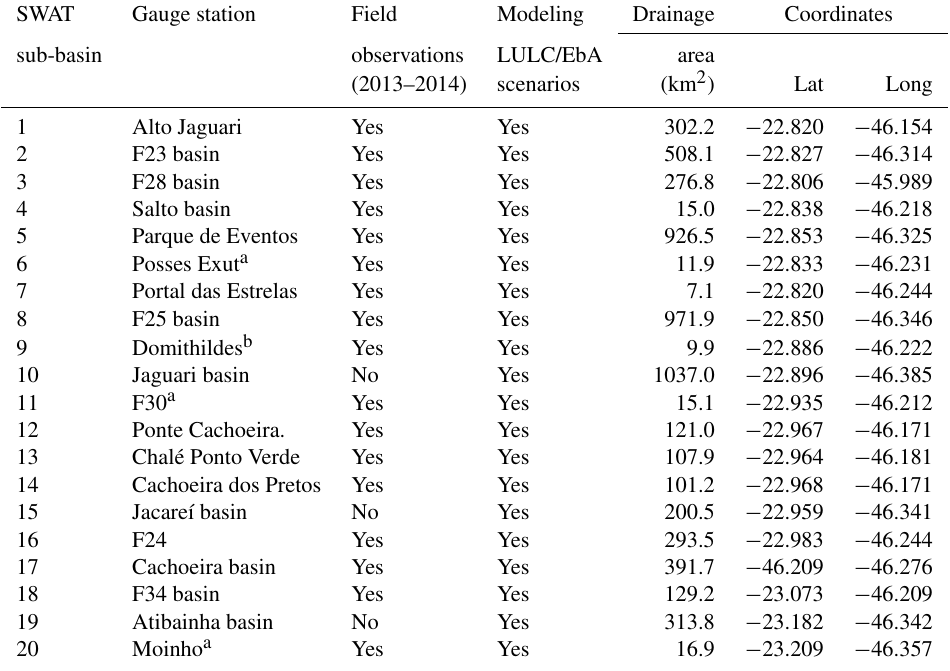
Table 1. Sub-basins delimited in SWAT with drainage areas and geographic locations. SWAT Gauge station Field Modeling Drainage Coordinates sub-basin observations